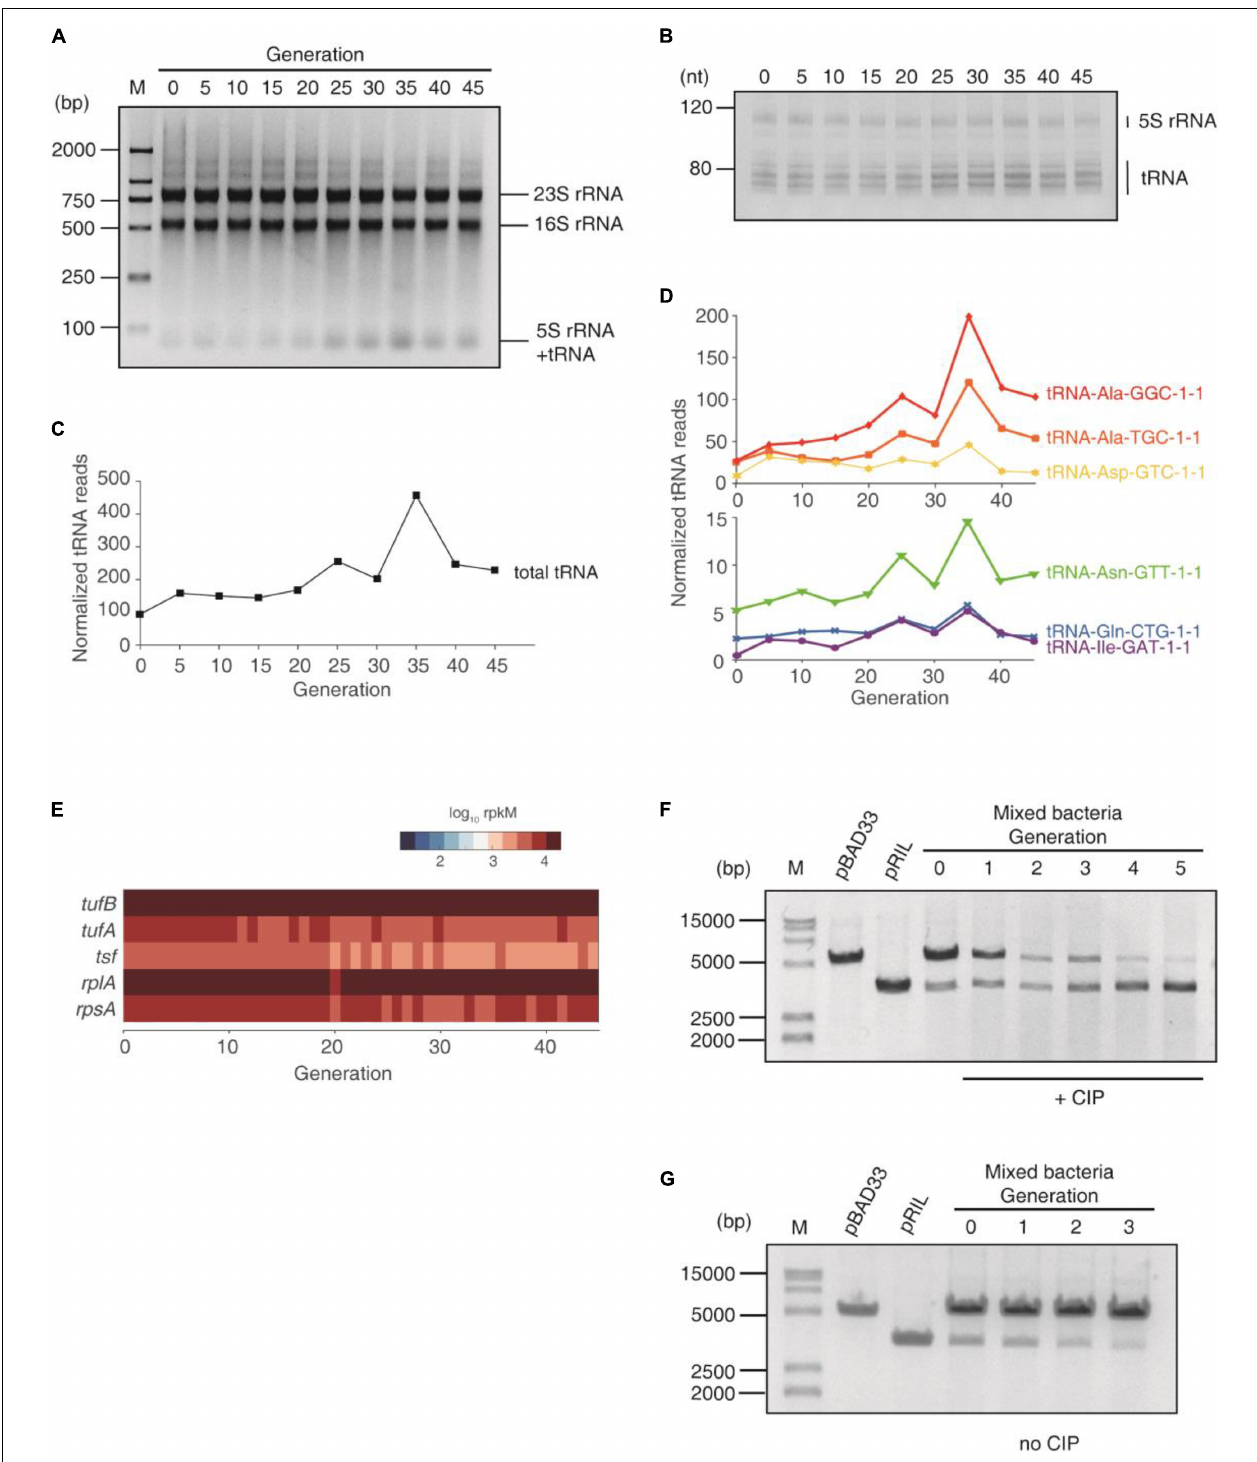
FIGURE 3 | tRNA up-regulation under the CIP stress. (A) Agarose gel of total RNA of each generation. Equal amounts of total RNA was loaded. (B) Polyacrylamide gel of total RNA of each generation. (C) Total tRNA abundance of each generation, quantified using tRNA-seq, normalized using artificially synthesized tRNA spike-in. (D) The abundance of 6 most abundant tRNAs during the subculturing, normalized using the spike-in. (E) The expression of elongation factors and ribosomal proteins. (F,G) The competition assay. pBAD33 and pRIL plasmids were transformed into E. coli BW25113, respectively, and mixed to start subculturing. For each generation, the plasmids were extracted from the mixture. (F) Subculture with CIP. (G) Subculture without CIP.